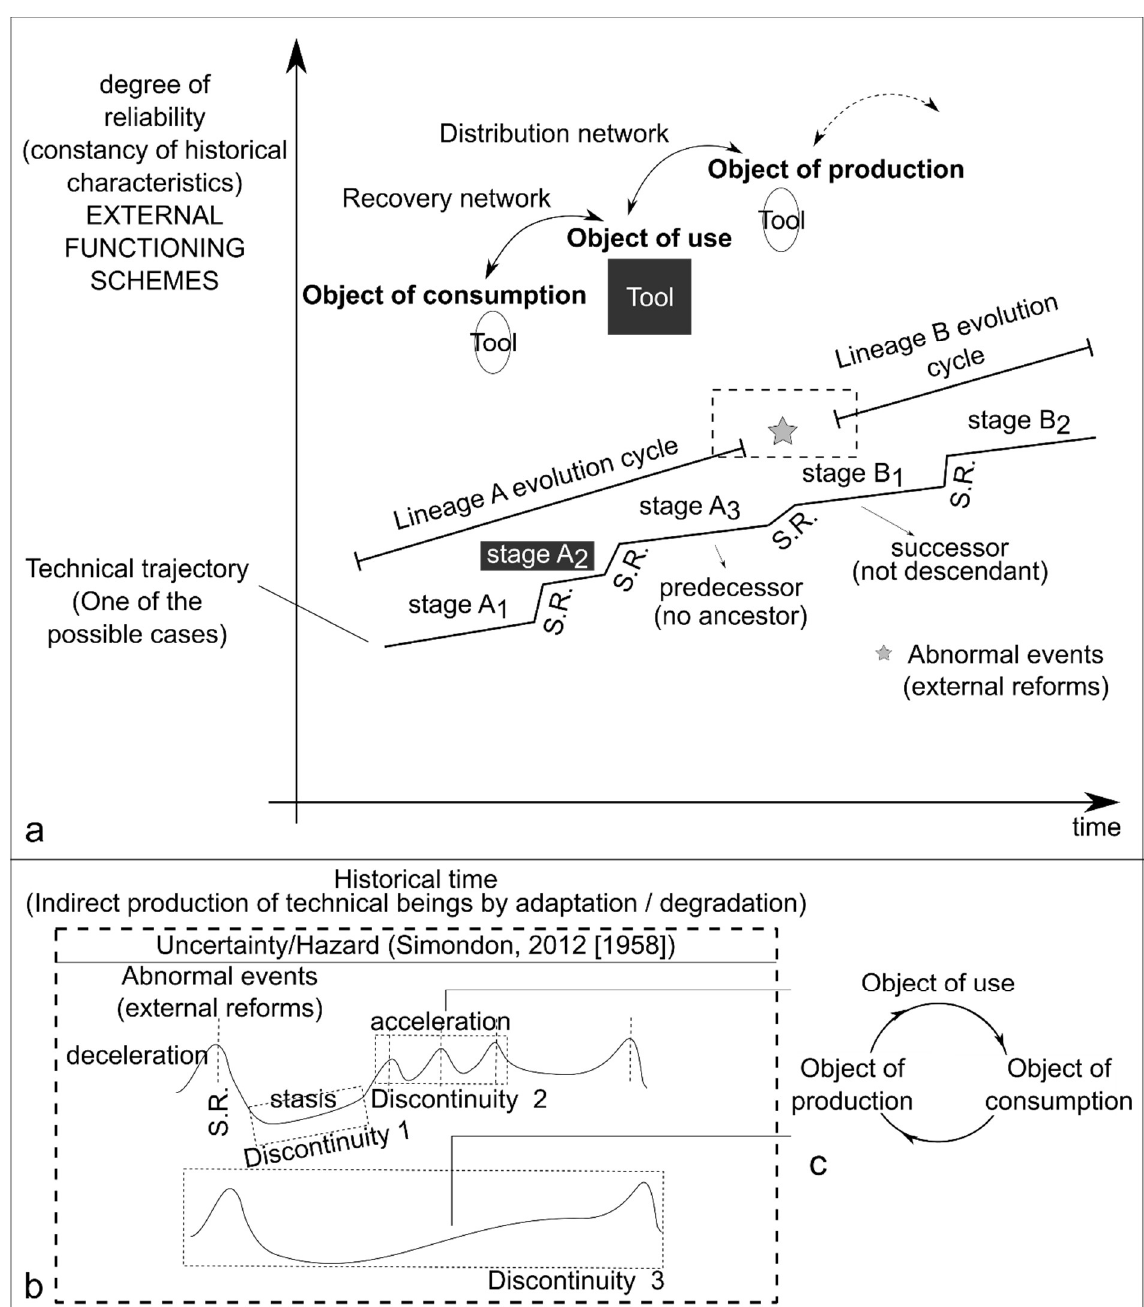
Figure 15. Structure of prehistoric technical trajectories: (a) General definition, (b) role of hazard in internal transformations, (c) psychosocial transformations of